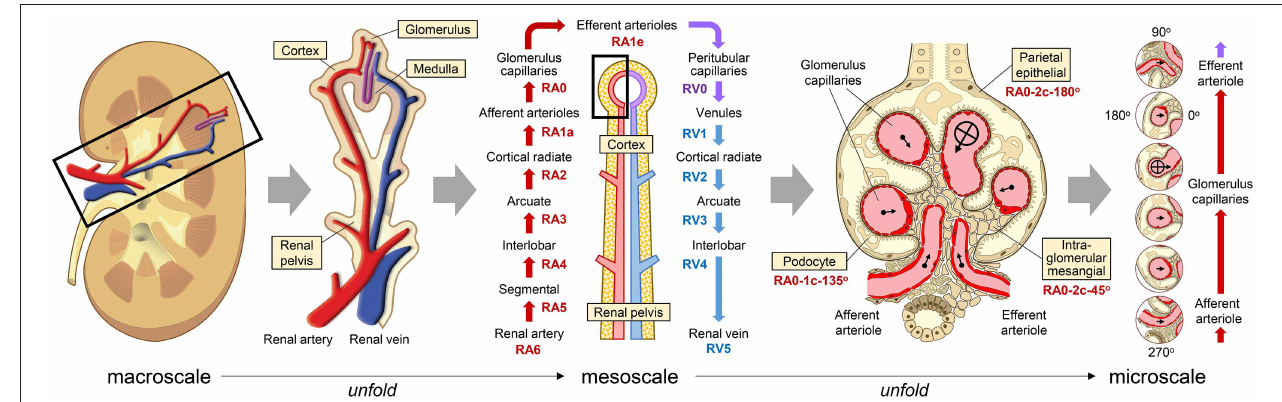
FIGURE 2 | Unfolding the renal vascular pathway down to the single cell level. A representative vascular pathway enters the kidney through the renal artery, passes through the glomerulus, and returns out the renal vein. At the macroscale (left) and mesoscale (center), labels in yellow boxes are anatomical structures that correspond to different vessels along this loop. At the microscale (right), labels in yellow boxes are different types of cells that are within a short distance of a nearby vessel in the glomerulus. The position of individual cells can be described by the nearest vessel’s address (e.g., “RA0” for glomerulus capillary), the distance in micrometers or number of cells from the vessel endothelium and an angle perpendicular to the length of the vessel (e.g., “RA0-10 µ m-135 ◦ ” or “RA0-1c-135 ◦ ”). On the far right, each vessel and its surrounding tissue has been extracted from the original image and aligned vertically to make it easy to see how cell types and distribution change along the vascular pathway. In this example, the aligned images have also been rotated so that the center of the glomerulus is always on the right. Source Files: Images of the kidney and glomerulus are adapted from Wikimedia Commons: https://commons.wikimedia.org/wiki/File:KidneyStructures_PioM.svg (CC BY 3.0 license); and, https://commons.wikimedia.org/wiki/File:Renal_corpuscle-en.svg (CC BY-SA 4.0